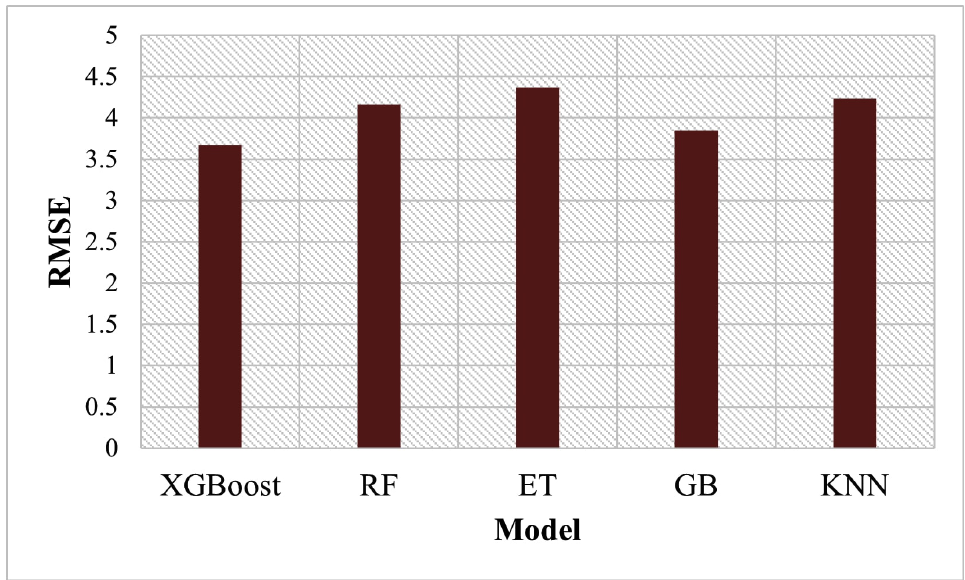
Figure 4. RMSE values of the ML models for a combination of CNN + GLCM features and non- image